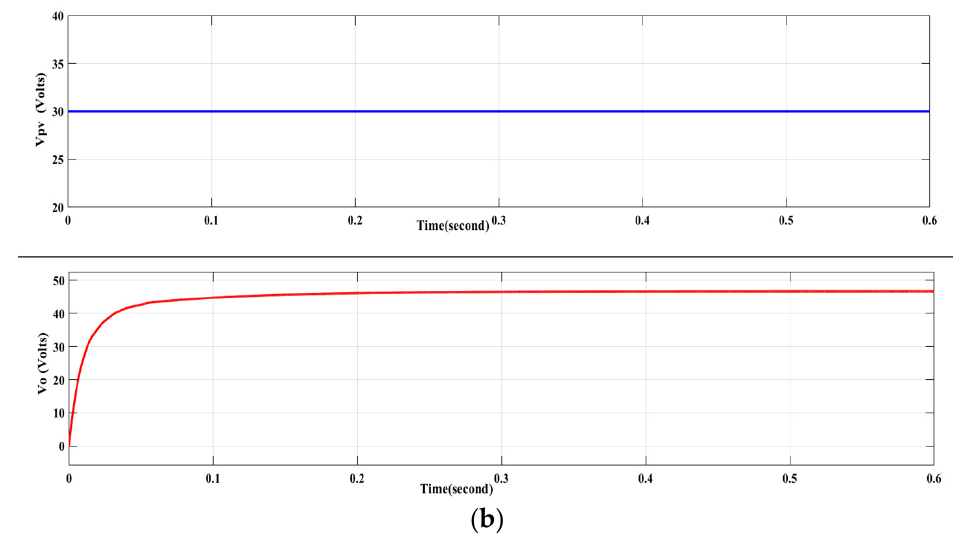
Figure 8. Simulation result of the proposed IIABB converter for solar PV module input voltage V pv of 30 V and corresponding output voltage V o = 48 V and number of connected inductors N = 3 with duty cycle 0.35 ( a ) gate pulse waveform where S A and S D are in operating condition and S B and S C are not operating, and ( b ) the V pv and output voltage V o .